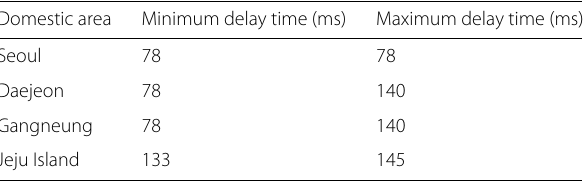
Table 1 Experimental verification of the domestic voice communication test